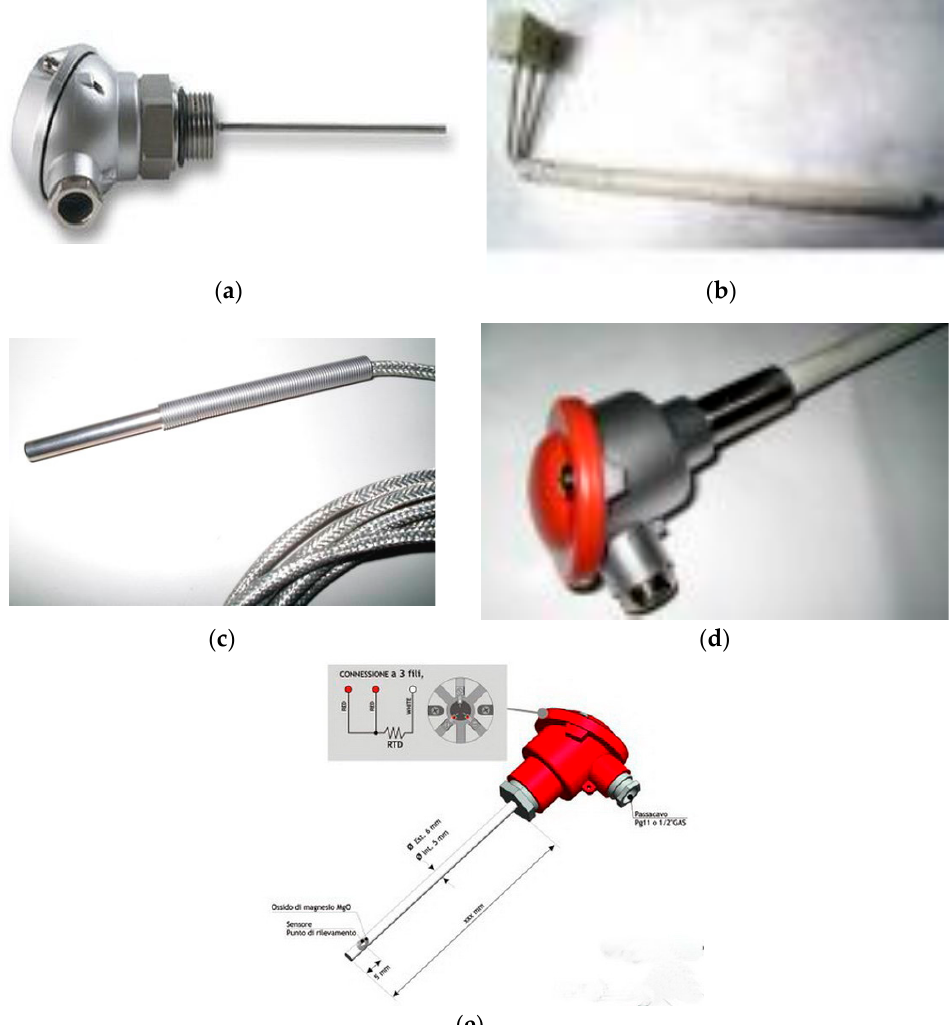
Figure 6a–e show images of the temperature sensors used in the conducted research.